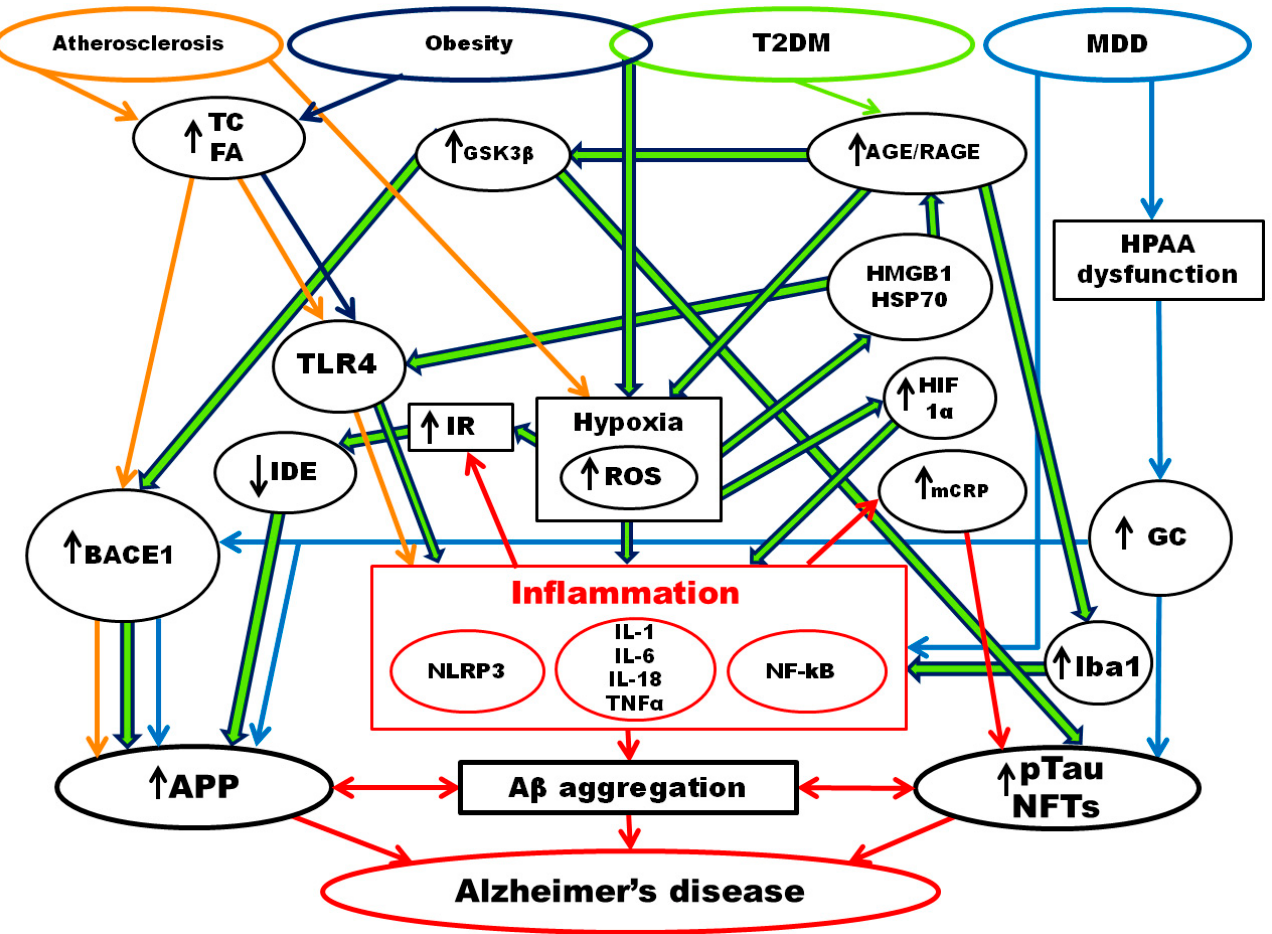
Figure 1. Molecular mechanisms of the relationship between chronic inflammatory diseases and AD. T2DM—type 2 diabetes mellitus; MDD—major depressive disorder; TC—total cholesterol;